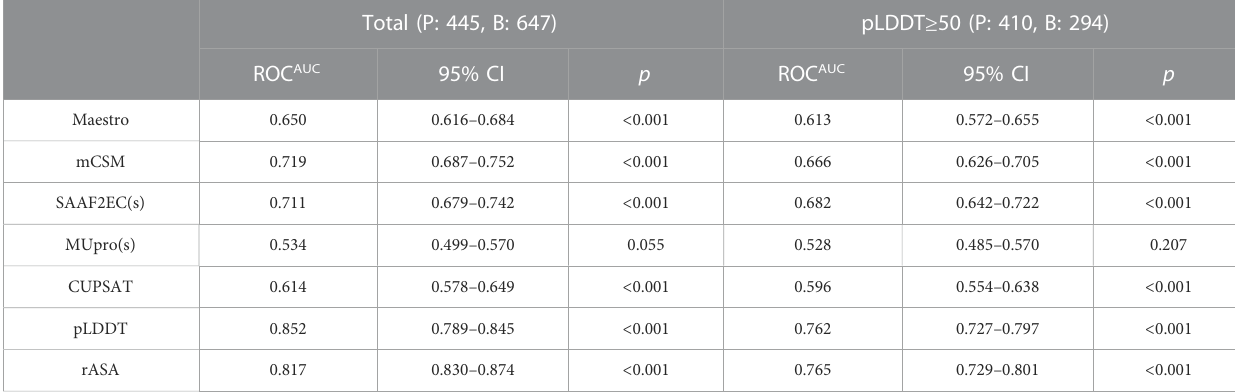
TABLE 4 Area under ROC curve of scores from fi ve stability predictors and two structural